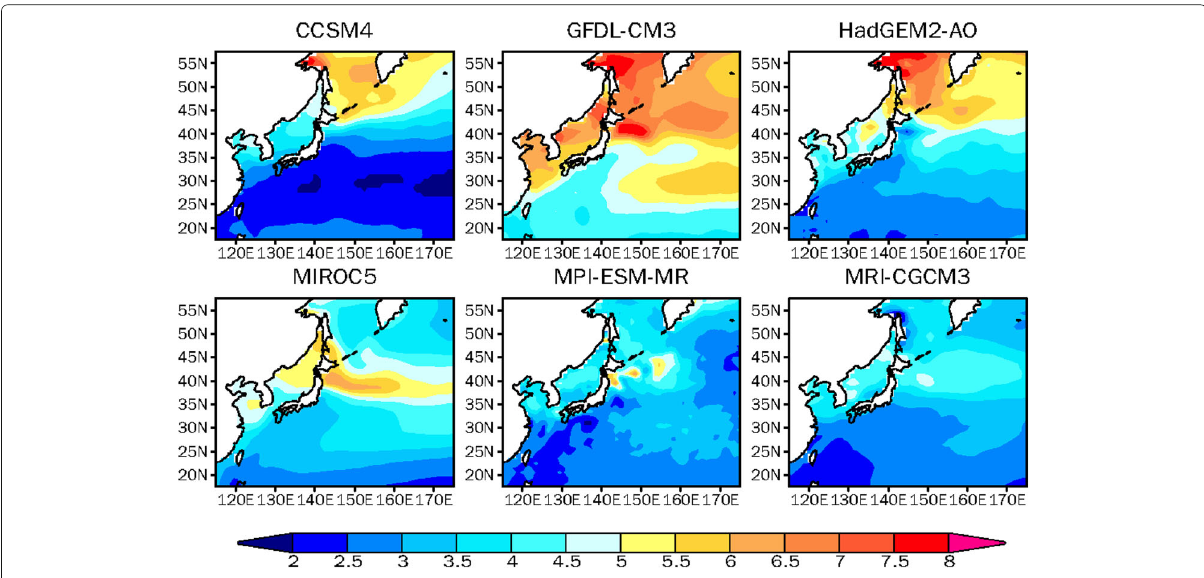
Fig. 12 Same as Fig. 2, but for seas around